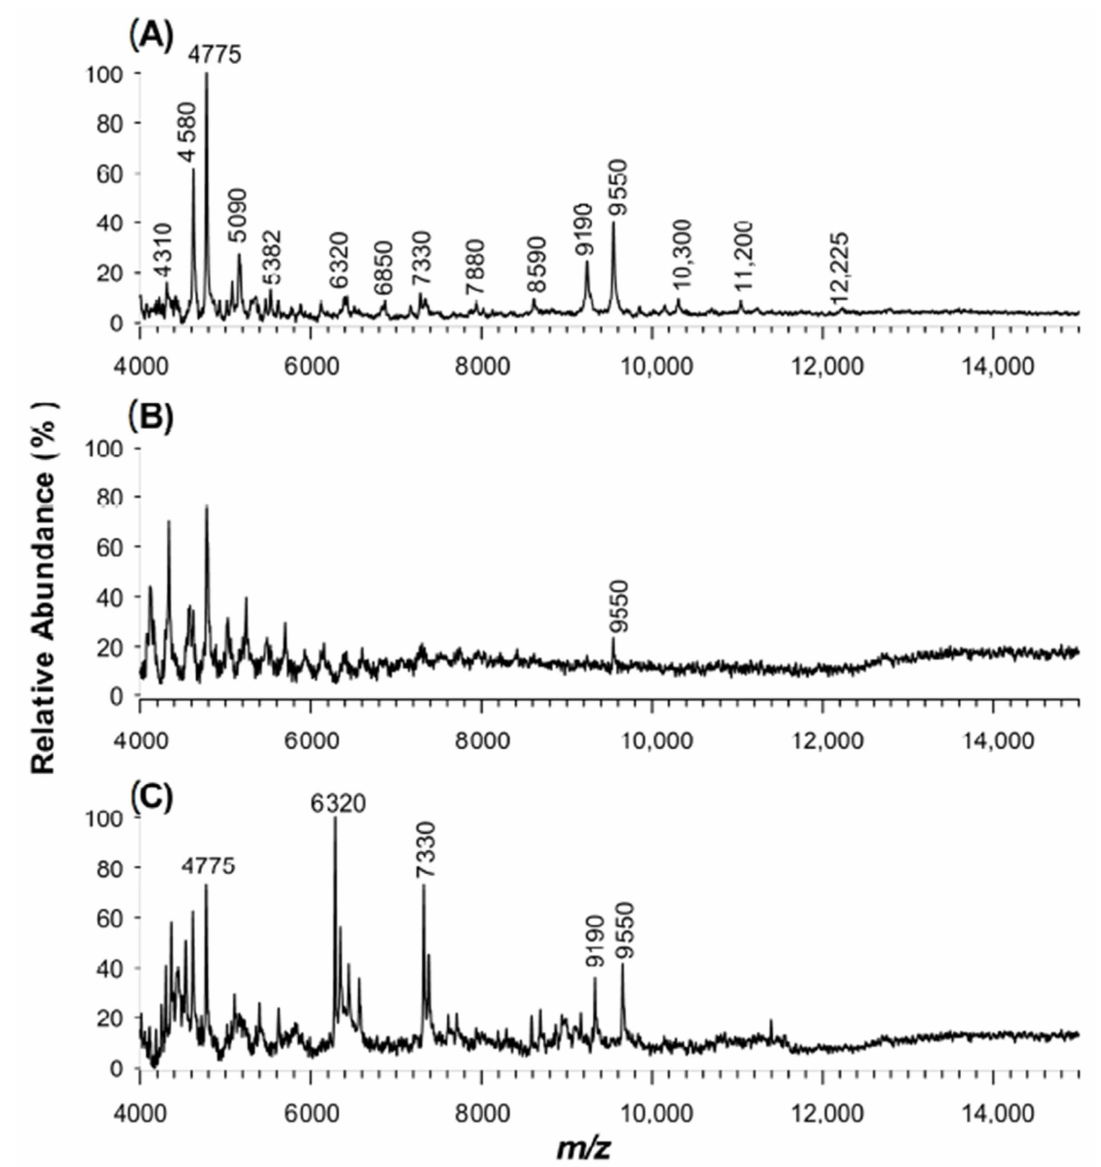
Figure 7. Positive MALDI-TOF MS spectra of E. coli cell culture (10 4 cfu / mL) after mixing with ( A ) CPPA, ( B ) CHCA or ( C ) CClCA as the matrix. For signal attribution, see Table 1. Regarding MALDI-TOF mass spectra comparison, CPPA enabled obtaining a better protein fingerprint using lower laser energy and improved intra-spot and spot-to-spot repeatabilities, eliminating the laborious searching for ‘sweet’ points, with a resulting tenfold higher S / N ratio. Through this targeted approach, MALDI-MS can be used as a fast-analytical tool to generate protein profiling of di ff erent microorganisms, fungi and food compounds in a relatively short time and without significant sample